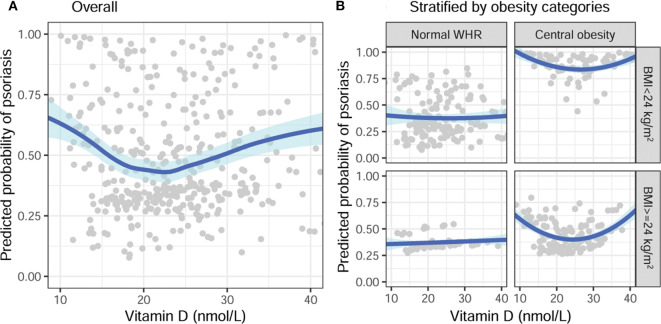
Adjusted association of vitamin D with a predicted probability of psoriasis, stratified by obesity categories, adjusted for age and gender. (A) Overall and (B) stratified by BMI and WHR categories. BMI, body mass index; WHR, waist-hip ratio.